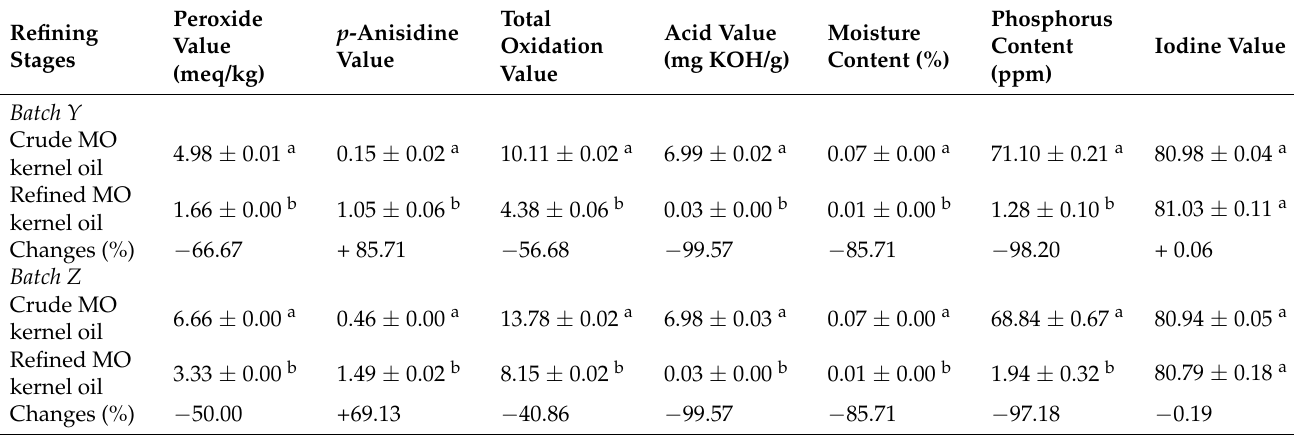
Table 4. Changes in the physicochemical and oxidative properties of refined Moringa oleifera (MO) kernel oil (Batches Y and Z refined by degumming, neutralization, and